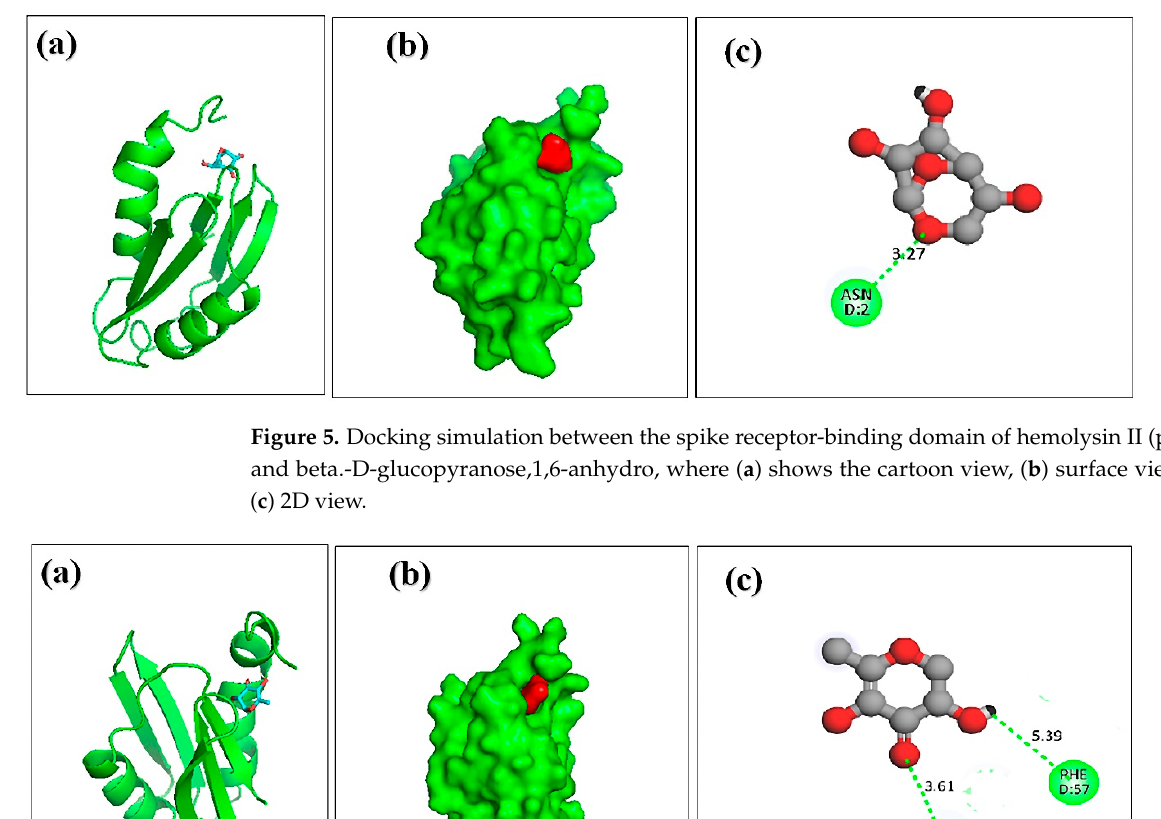
Figure 4. Docking simulation between the spike receptor ‐ binding domain of hemolysin II (protein) and 2,4 ‐ dihydroxy ‐ 2,5 ‐ dimethyl 3(2H) ‐ furan ‐ 3 ‐ one (furan), where ( a ) shows the cartoon view, ( b ) surface view, and ( c ) 2D view.